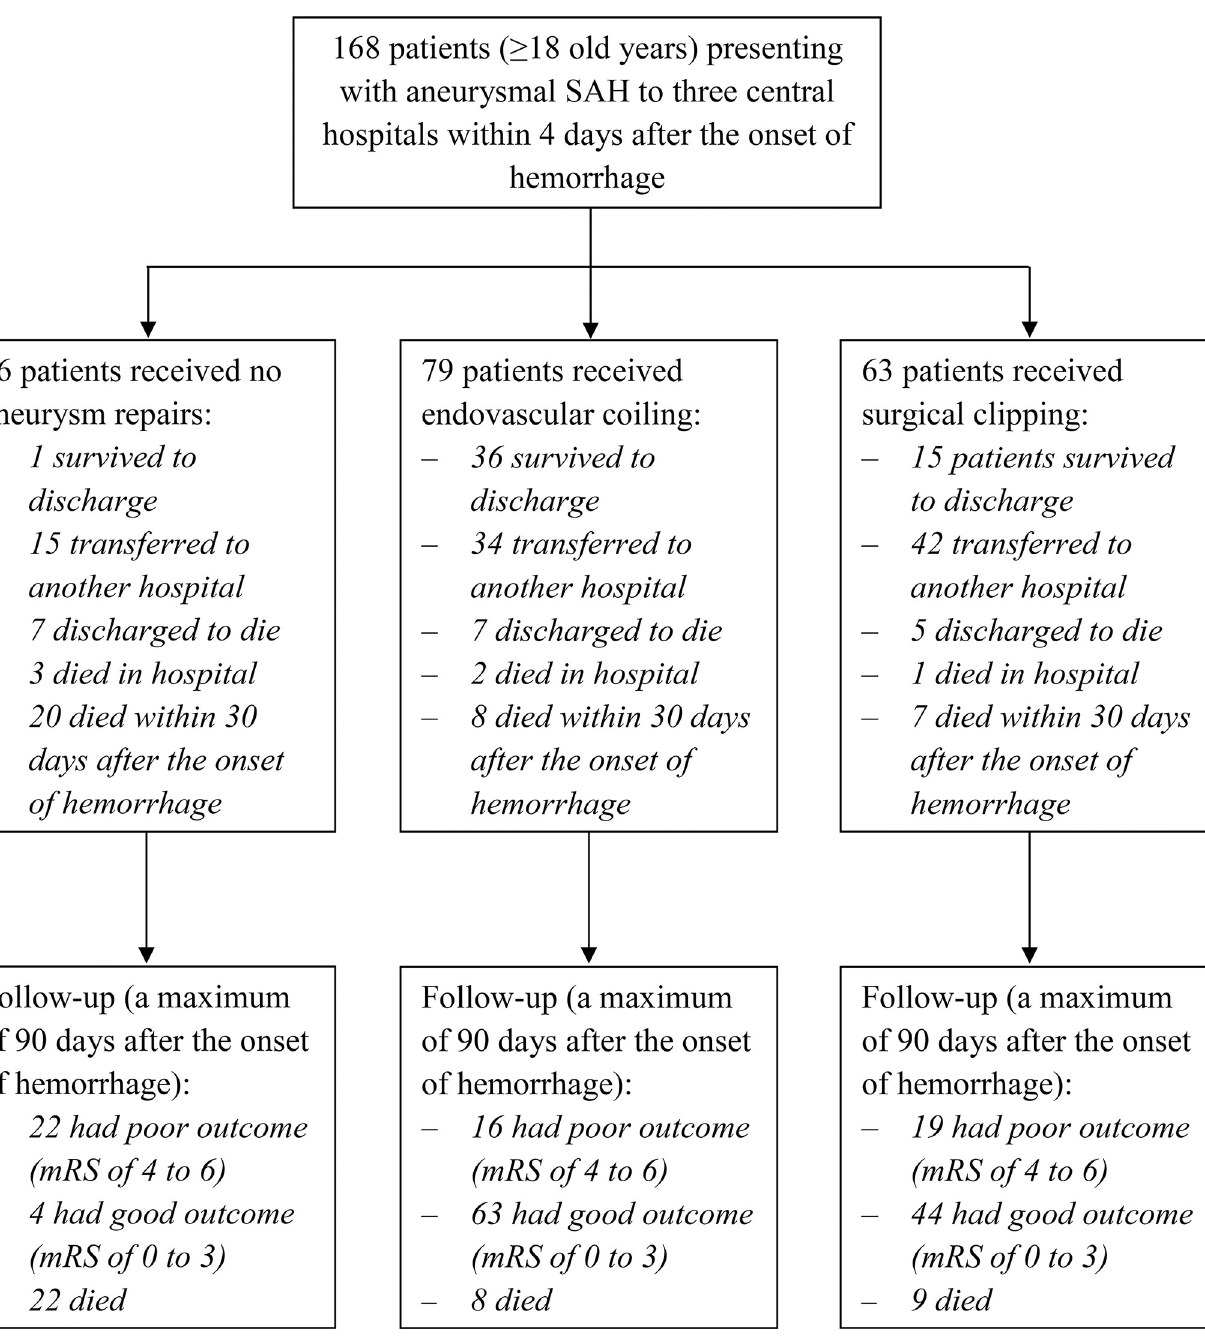
PLOS ONE | https://doi.org/10.1371/journal.pone.0256150 August 13,